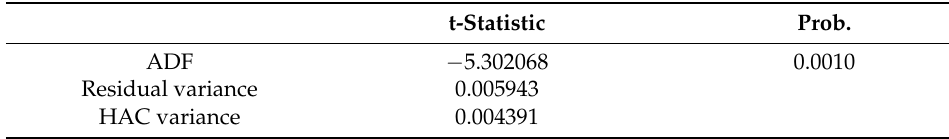
Table 5. Results for Kao co-integration test.